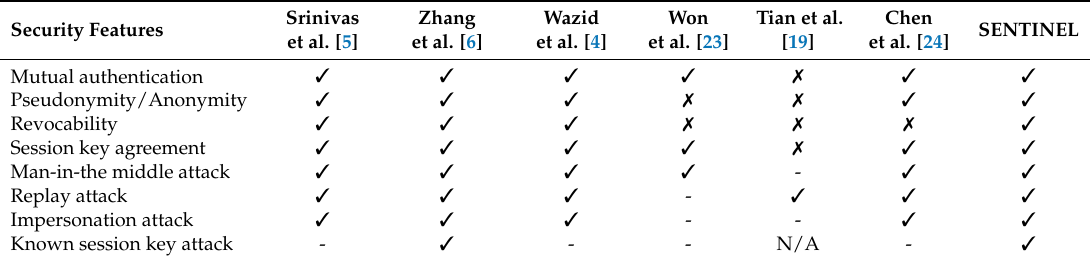
Table 5. Summary and comparison of existing authentication protocols for IoD and our solution (‘-’ indicates that the paper did not mentioned them and ‘N/A’ indicates that the attack cannot be performed because there is no session